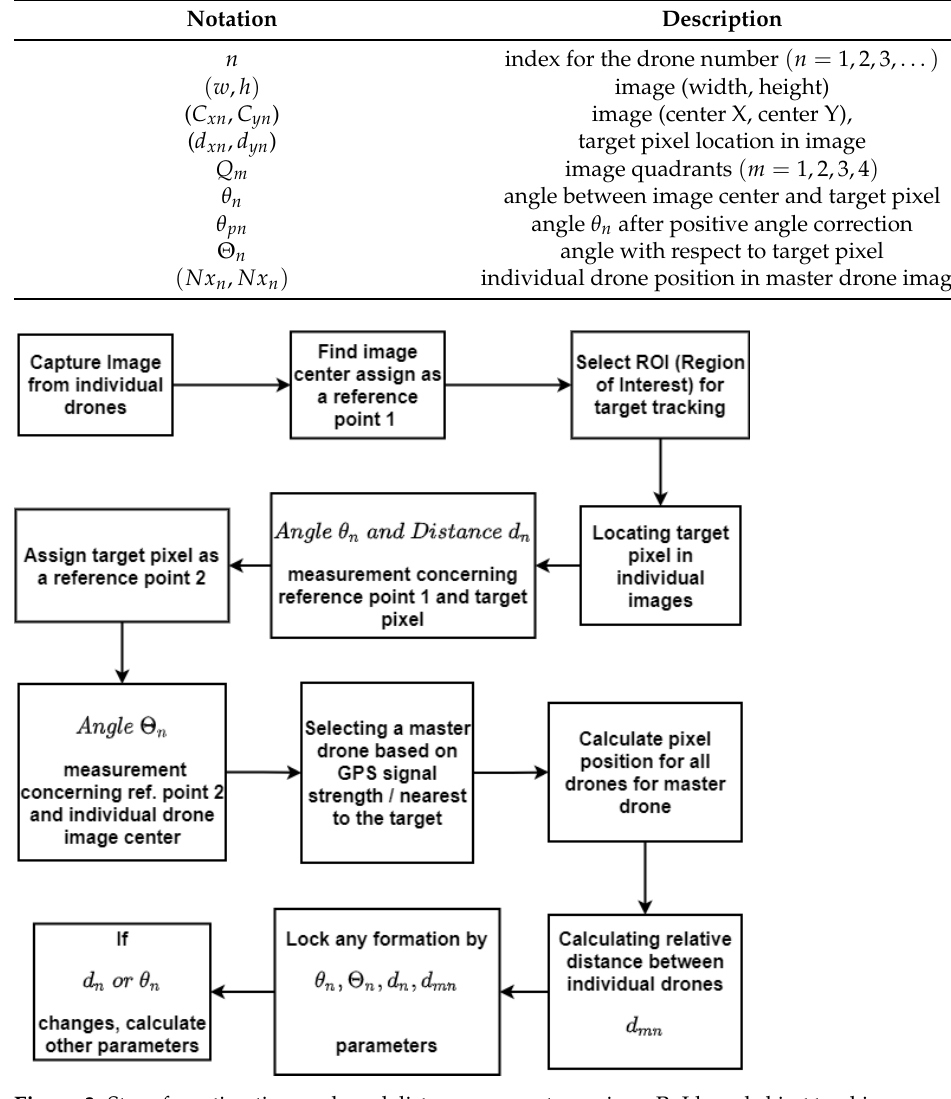
Figure 3. Steps for estimating angle and distance parameters using a RoI-based object tracking